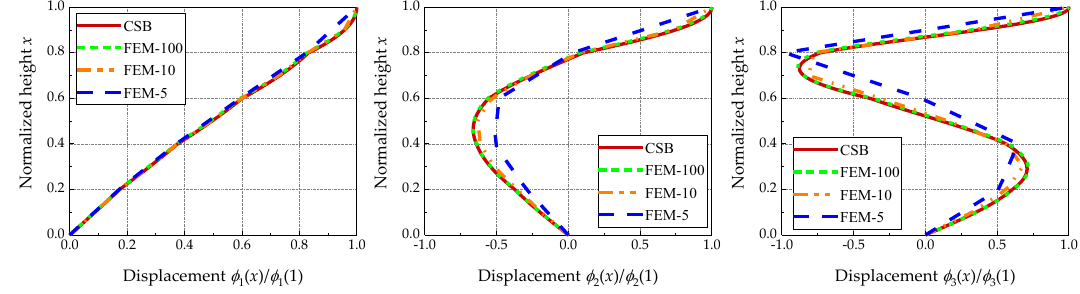
Figure 4. The influence of the number of degrees of freedom.